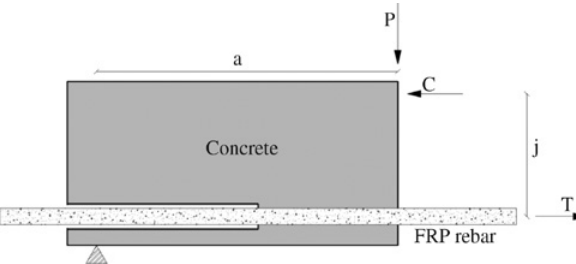
Figure 3: Theory of ultimate equilibrium on beam